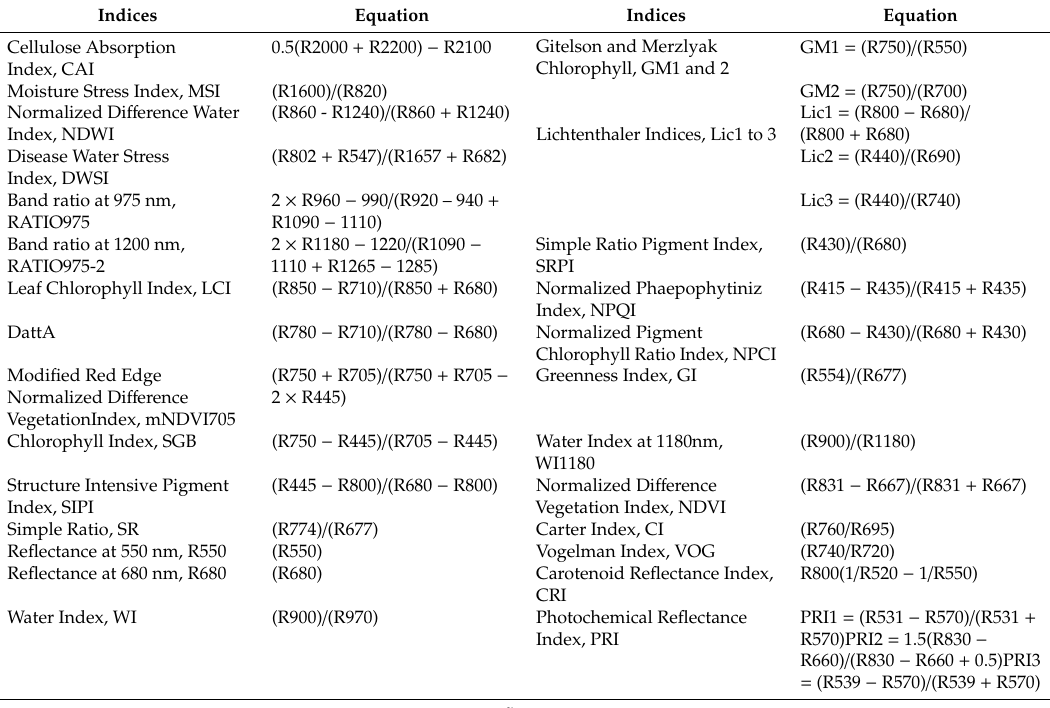
Table 1. Characteristics of studied hyperspectral indices